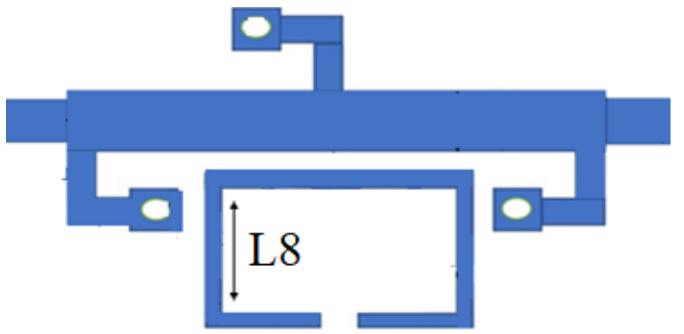
Figure 6. The proposed C-shaped resonator topology for the 8.3 GHz stopband.